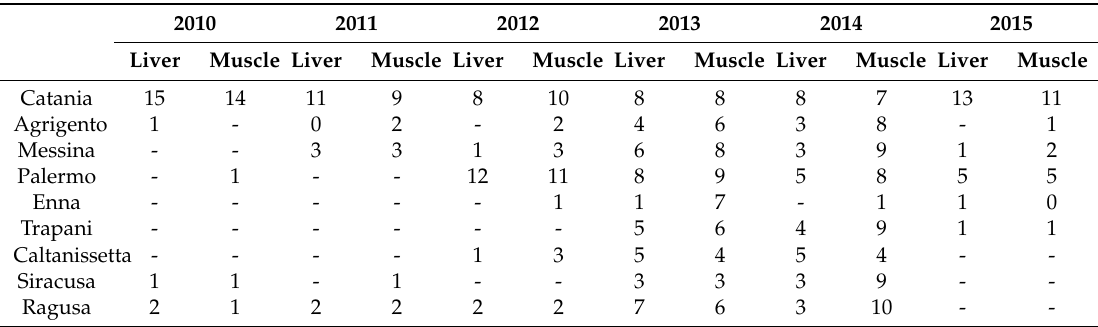
Table 3. Number of bovine liver and muscle samples analyzed for the detection of tetracyclines sorted by sampling